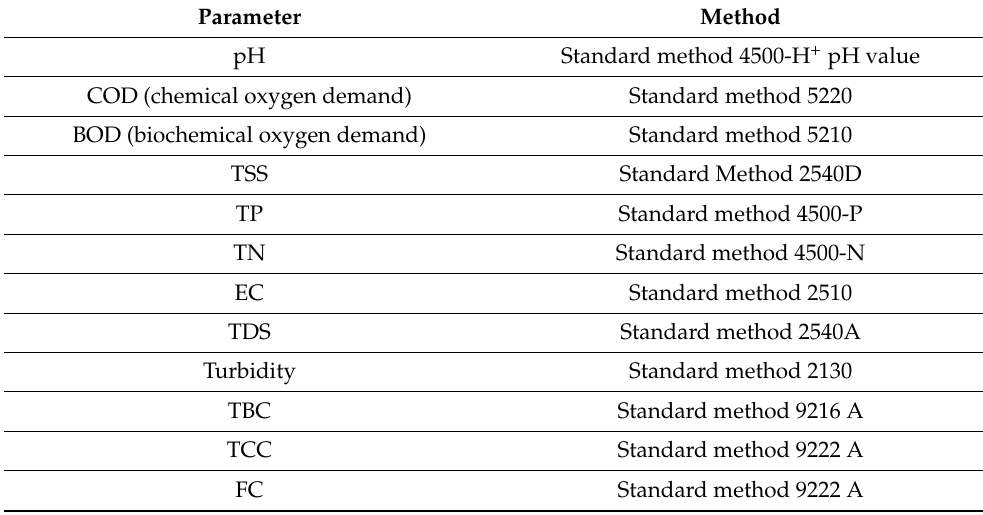
Table 4. Analytical